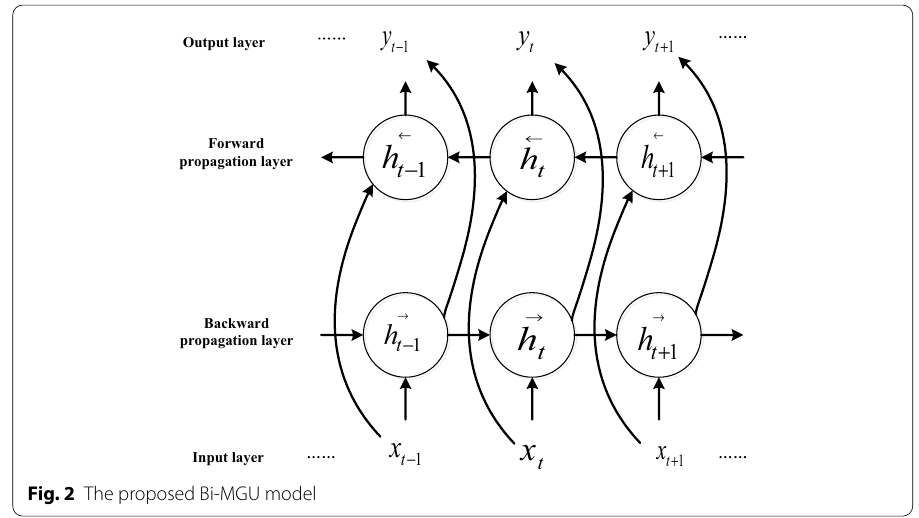
Fig. 2 The proposed Bi-MGU